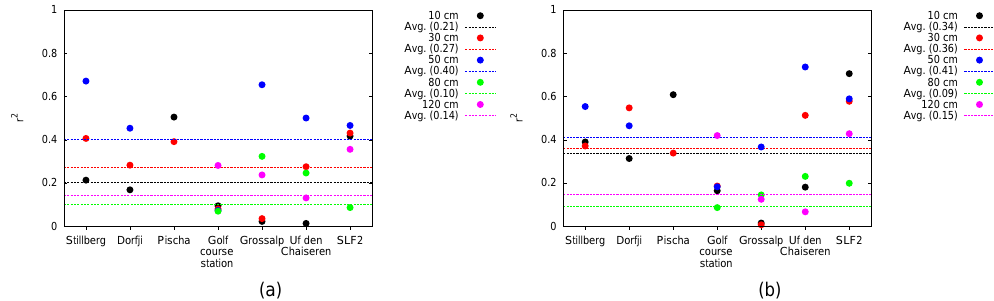
Figure 8. The r 2 values between measured and simulated soil moisture for the full period (a) and the summer months (b) for the seven soil moisture stations. Dashed lines indicate the average value determined over all stations.